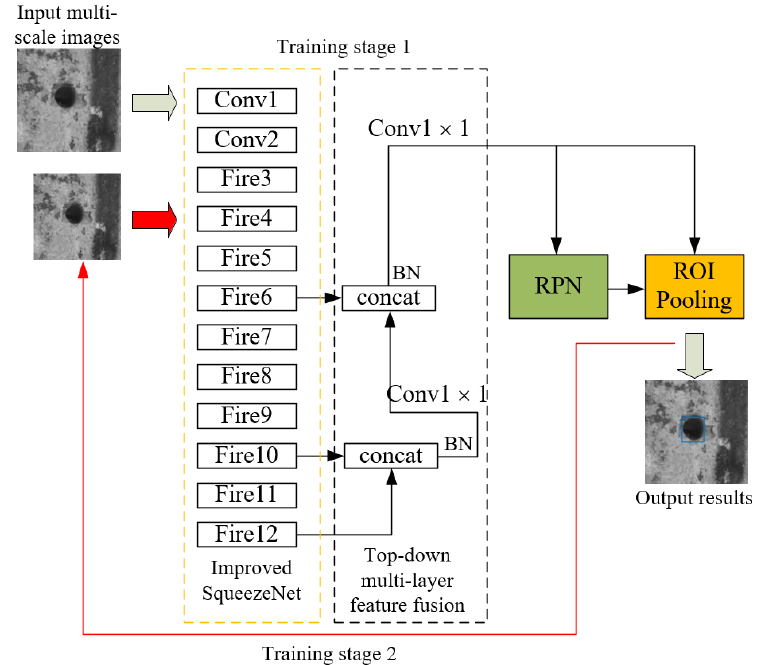
Figure 7. Improved Faster R-CNN model for pressure relief hole target recognition.